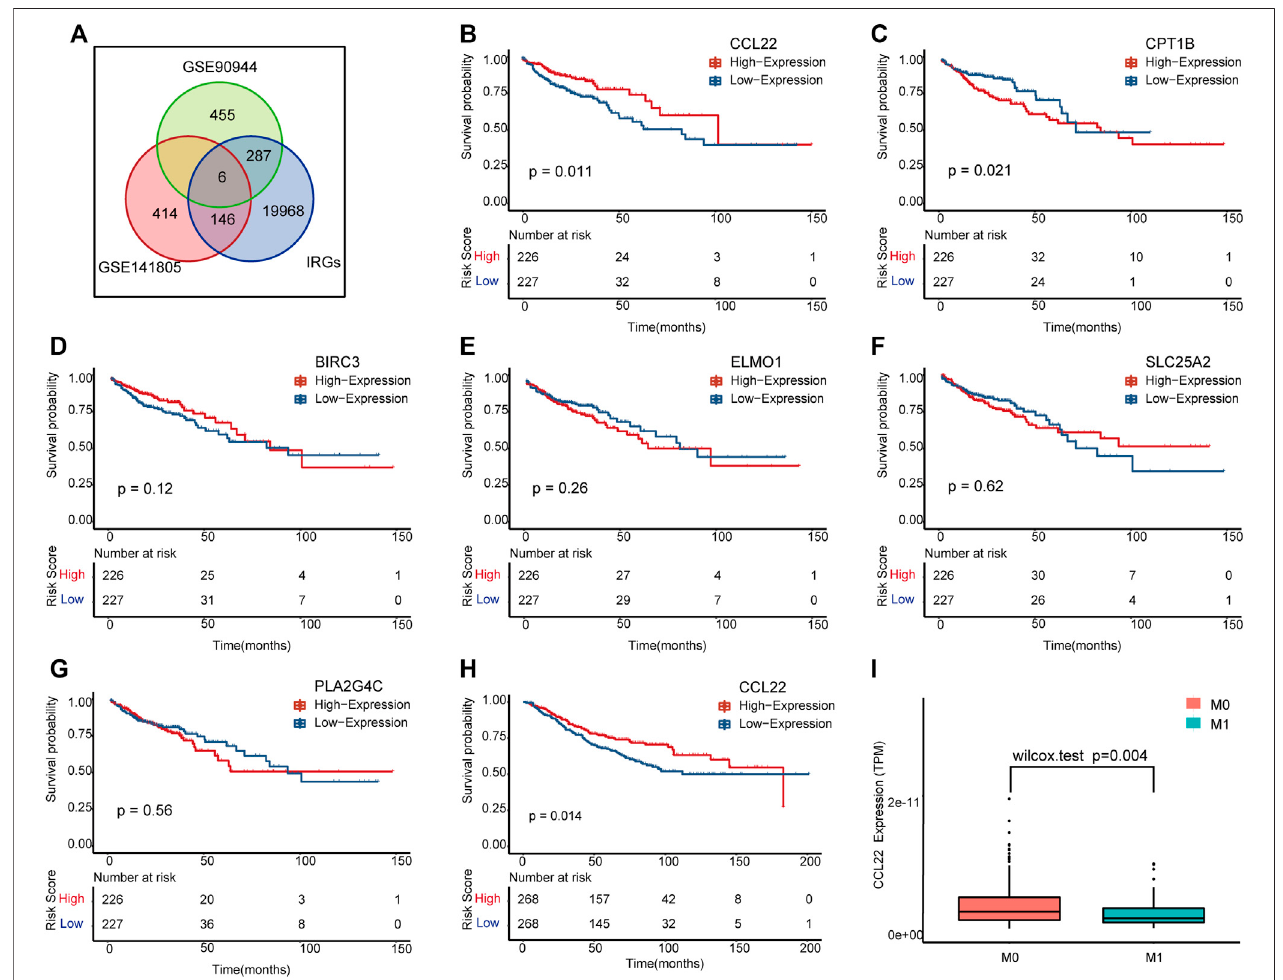
FIGURE3| Themeaningfulimmune-related(IR)differentiallyexpressedgenes(DEGs)in fl uencedby F.nucleatum . (A) Venndiagramshowingthecommongenesin GSE90944, GSE141805, and immune-related genes. (B – G) Kaplan – Meier survival plots of the IR DEGs in The Cancer Genome Atlas (TCGA) colon adenocarcinoma (COAD). (H) Kaplan – Meier survival plot of CCL22 in GSE39582. (I) Box plot of CCL22 expression between M0 and M1 stages in TCGA COAD.